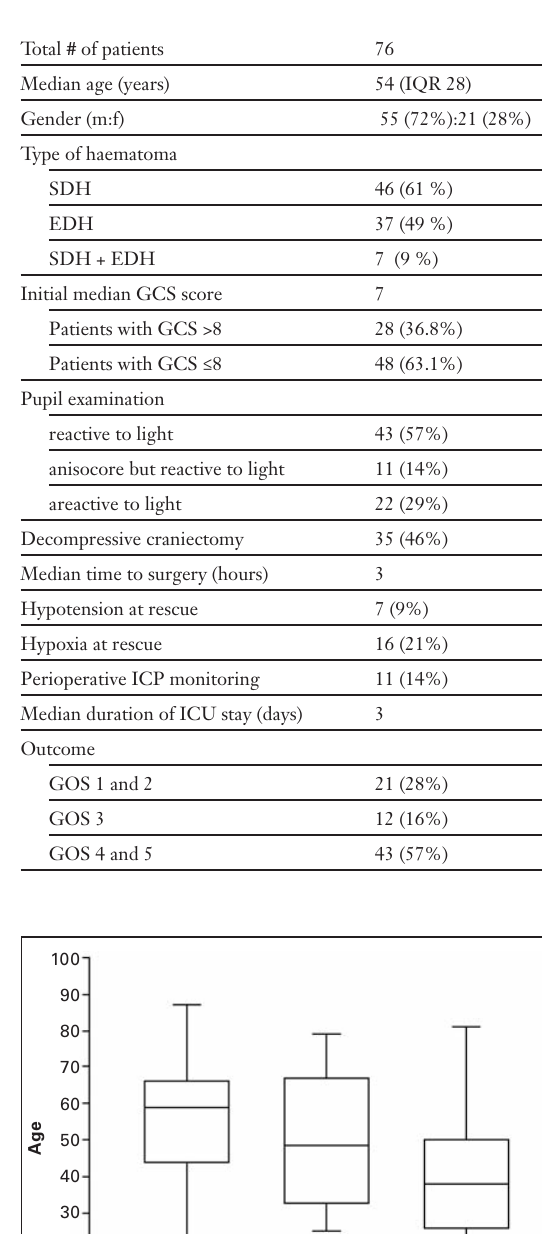
Summary of demo- graphic characteris- tics, clinical findings and outcome.